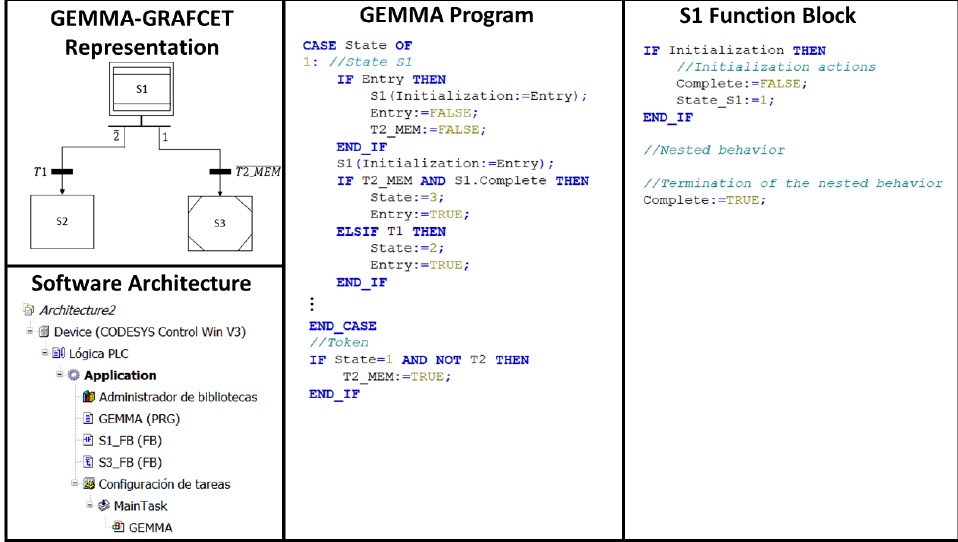
Figure 2. Application example of the GG-Representation and the